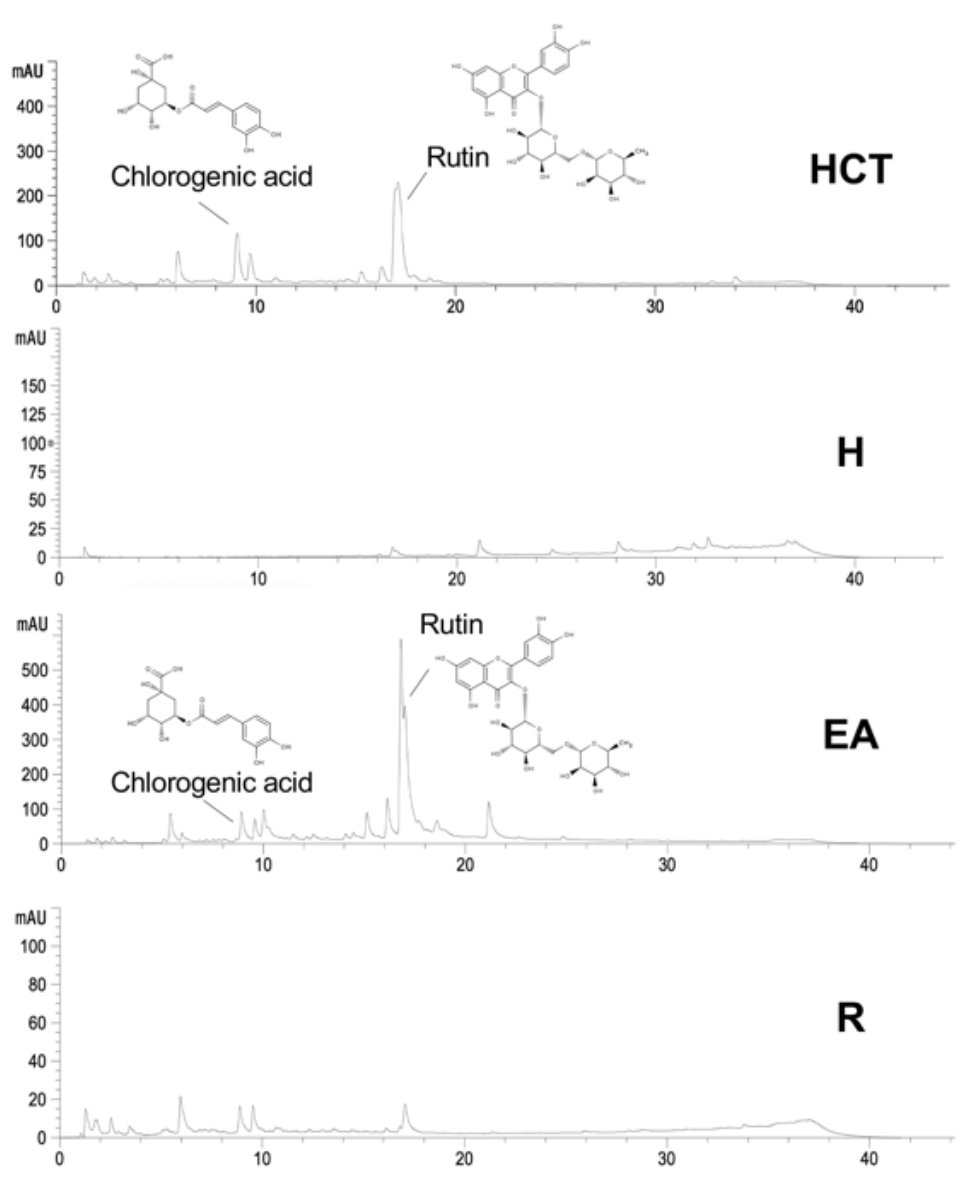
Figure 1. The level of rutin and chlorogenic acid of ethanolic H. cordata extract compared to hexane (H), ethyl acetate (EA), and residue fractions (R).